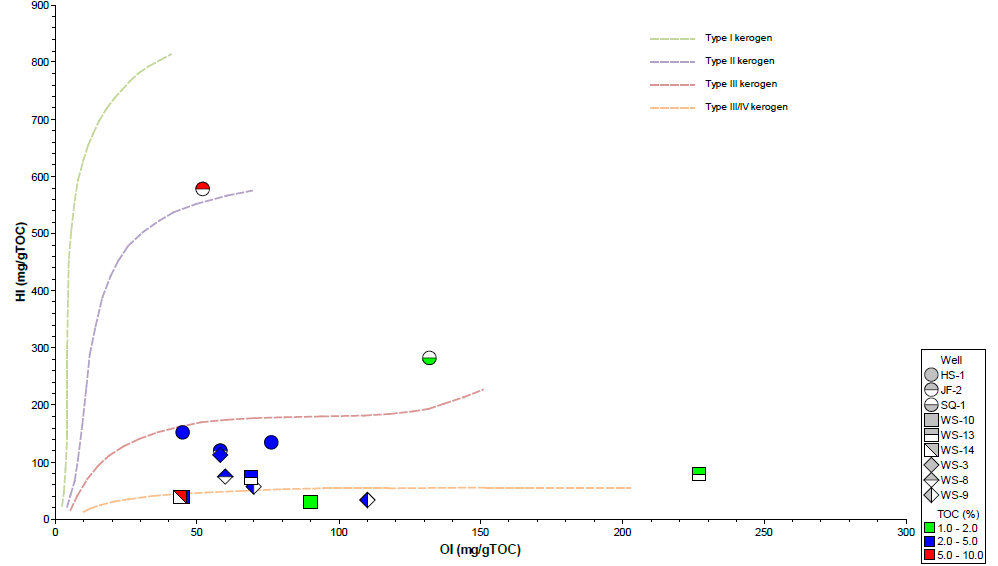
Figure 6. Pseudo van Krevelen plot of hydrogen index versus oxygen